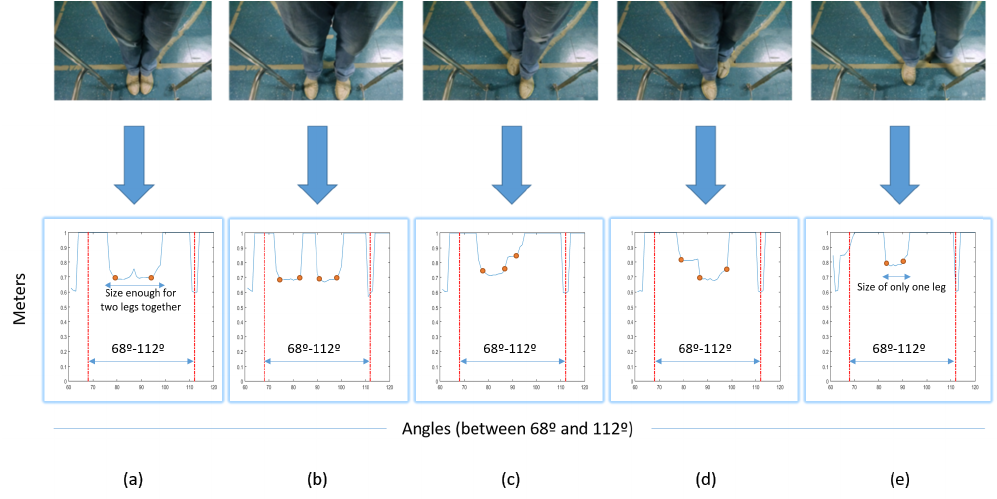
Figure 6. Diagram showing the operation of the leg detection algorithm. ( a ) Legs togheter - two transitions; ( b ) Legs separated - four transitions; ( c ) Three transitions - left leg closer to the laser sensor; ( d ) Three transitions - right leg closer to the laser sensor; ( e ) Only one leg